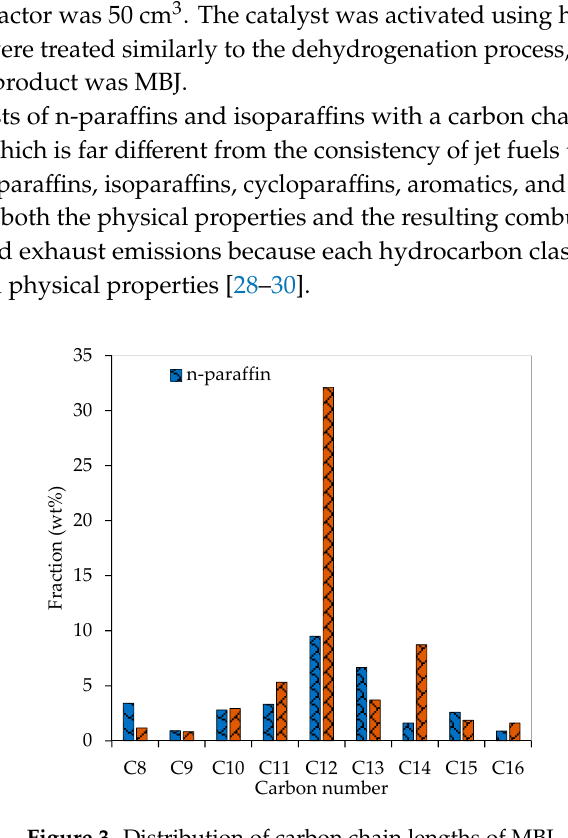
Figure 3. Distribution of carbon chain lengths of MBJ.